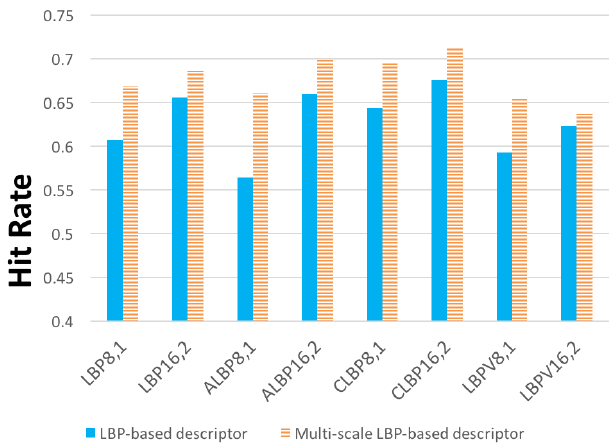
Figure 9. Hit rates for LBP-based descriptors LBP, ALBP, CLBP and LBPV and their multi-scale